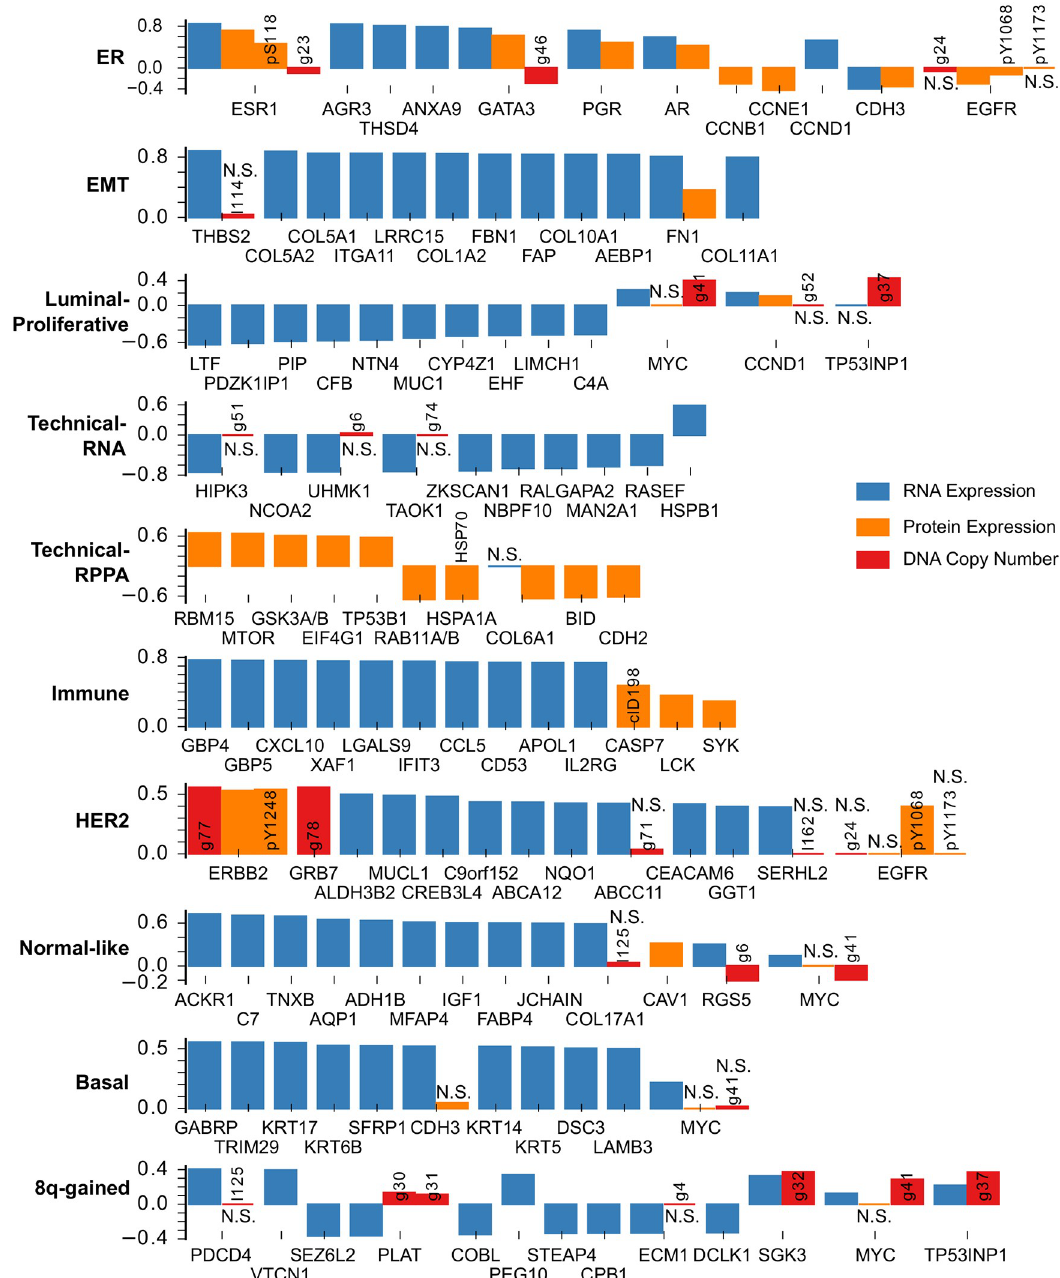
Fig 2. The strongest sparse-factor analysis coefficients for the breast cancer data set for each of the three data types and all ten factors. The height of the bars shows the values of the coefficients. Non-significant coefficients (p > 0.05, signifance test of coefficient in an ordinary least-squares model) are marked with N.S. If a gene is strongly associated with a factor, we show all coefficients of that gene in the model. RNA expression coefficients are shown in blue. Protein expression coefficients are shown in orange. Any modifications of an epitope are noted in a short text description: pX = phosphorylated at residue X; clX = cleaved at residue X. DNA copy number coefficients are shown in red. Numbers refer to the recurrently aberrated loci in S5 Table. Recurrent gains are prefixed with a g, losses with an l. Also see S1